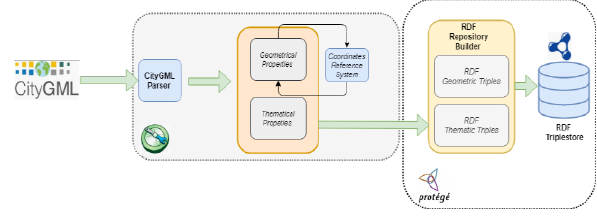
Figure 4: CityGML to RDF translation workflow